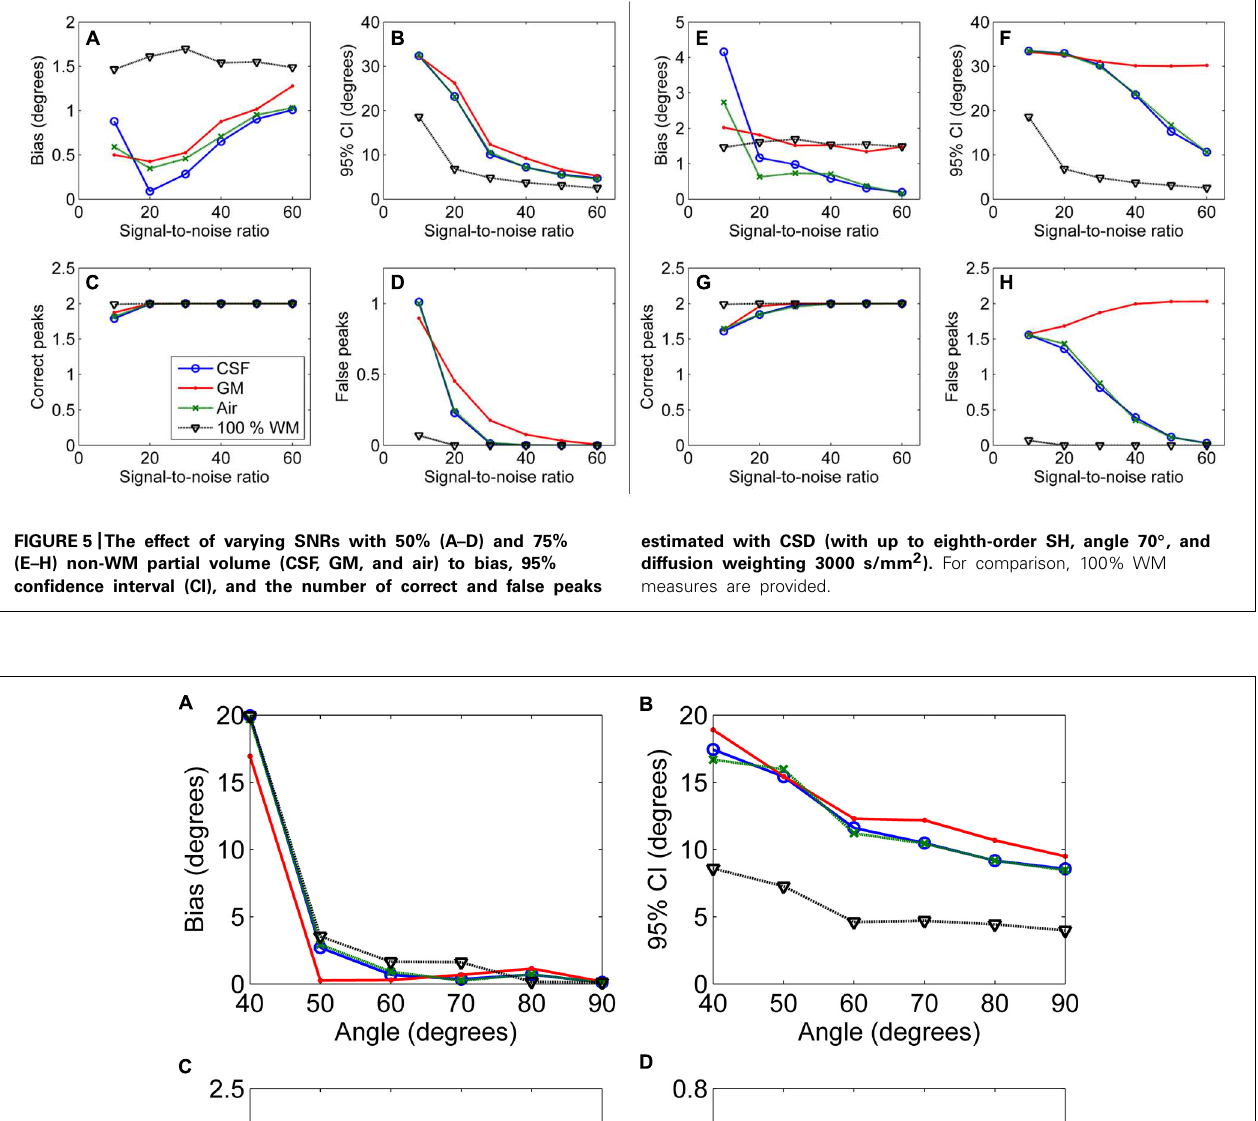
FIGURE 6 |The effect of varying angle between the two crossing fiber configurations with 50% non-WM partial volume (CSF, GM and air) to bias (A), 95% confidence interval (CI) (B), and the number of correct (C)